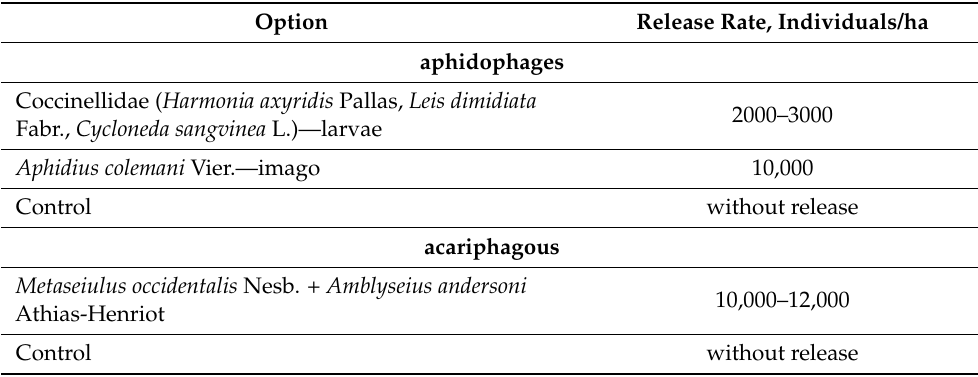
Table 1. Scheme of experiment in the use of aphidophagous and acariphagous species. Option